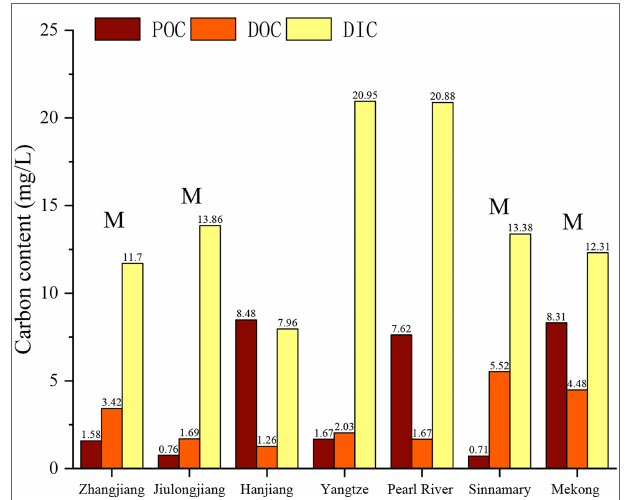
FIGURE 5 | Comparison of carbon compositions in different estuarine regions including ZJE, Jiulong Estuary (Liu et al., 2018), Hanjiang Estuary (Liu et al., 2018), Yangtze, Pearl River Estuary (Liu et al., 2018), Sinnamary Estuary (Ray et al., 2018), and Mekong Estuary (Liu et al., 2018). M indicates that there are mangroves located in the